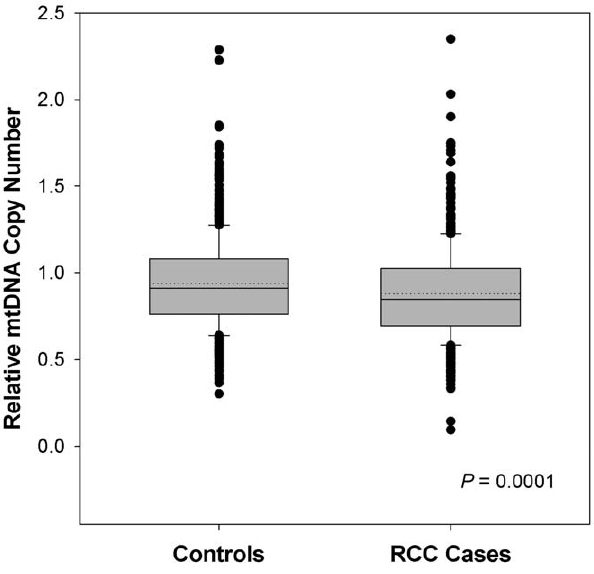
Figure 1. Peripheral blood mitochondrial DNA copy number in renal cell carcinoma cases and controls in The Kidney Cancer Study, 2002–2007. The box plots describe the median (solid line across the box), mean (dotted line), inter-quartile range and outliers (circles outside the ends of whiskers) for each study group. The P -value is from a comparison of mtDNA copy number distribution between cases and controls using the Wilcoxon rank sum test. consisted entirely of White participants. They did note findings suggestive of effect modification by smoking, which we did not observe in our study.